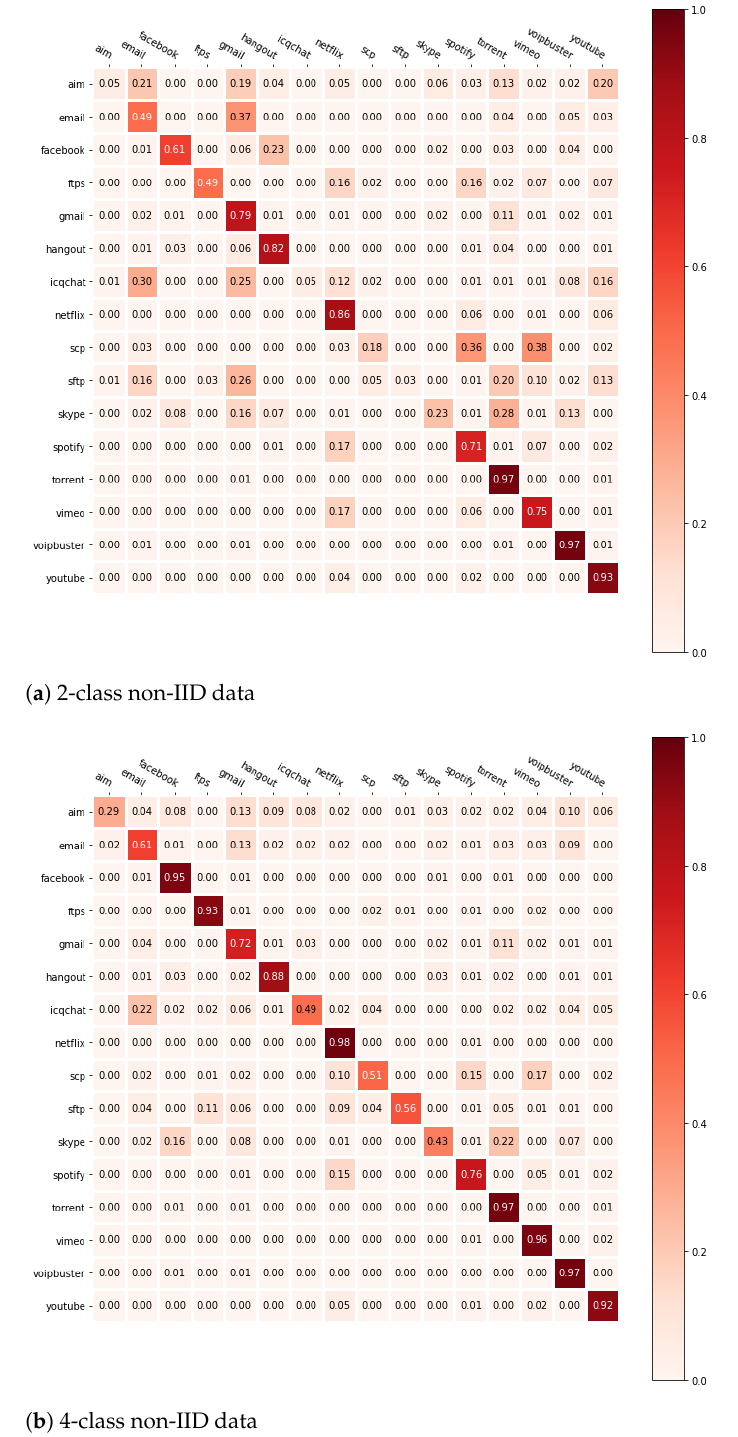
Figure 11. A confusion matrix of federated learning under 2-class and 4-class non-IID data. As shown in Table 3, as local epochs increase, the accuracy of 95% can be achieved in fewer rounds. In particular, as the local epochs increase, the rounds decrease, so when the local epoch is 30, 10.67 times fewer rounds can be